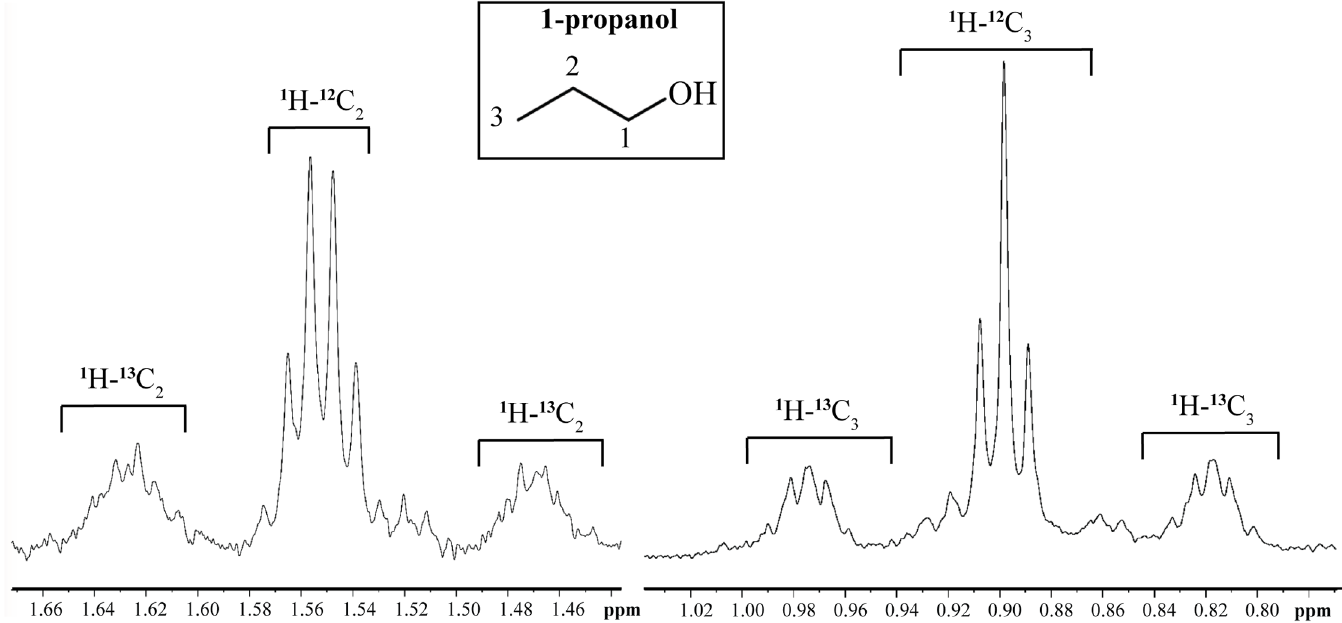
Fig 3. Incorporation of 13 C into 1-propanol from [U- 13 C] L-threonine. E . coli wild-typebiofilm was grown in M9 glycerolminimalmedium supplemented with a mixture of unlabeledL-threonine and [U- 13 C]L-threonine ( 13 C-enrichment was 44.5 ± 0.4%). Percent 13 C incorporated into the carbon positionis measuredby the area of the 1 H- 13 C signal relative to the total resonance area. Specific 13 C-enrichments on C 2 (41.4% ± 0.6%) and C 3 (42.4% ± 0.2%) indicatethe absenceof significantisotopic dilutionfrom 13 C –labeledthreoninewhen convertedinto 1-propanol.Insert: carbon positionsin 1-propanol.